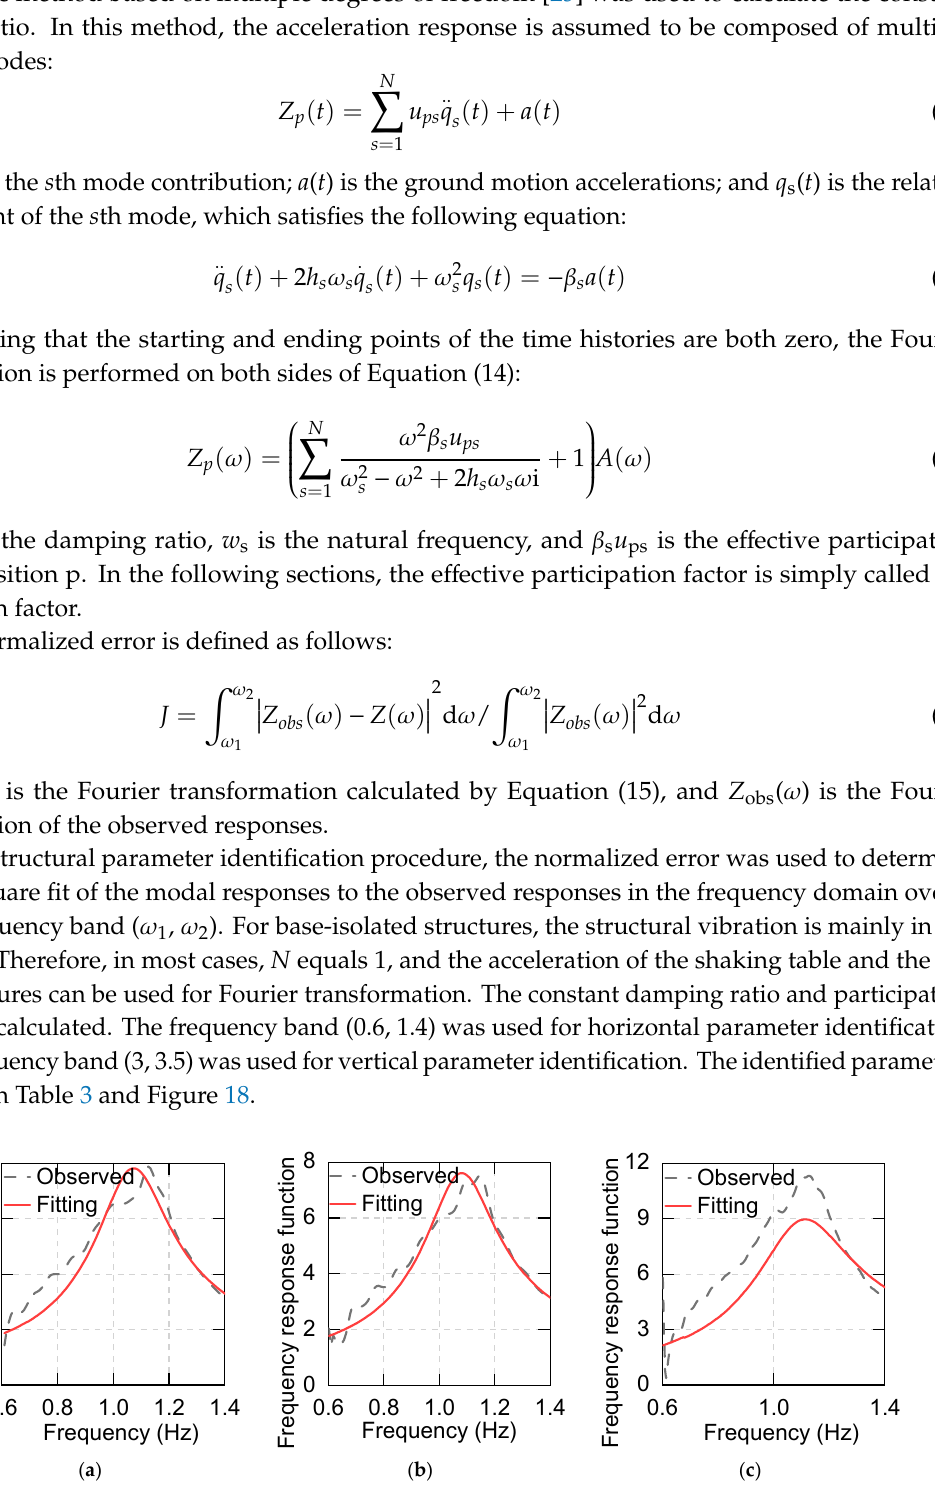
Figure 18. Horizontal parameter identification results: ( a ) test condition No. 22; ( b ) test condition No. 23; ( c ) test condition No. 24.